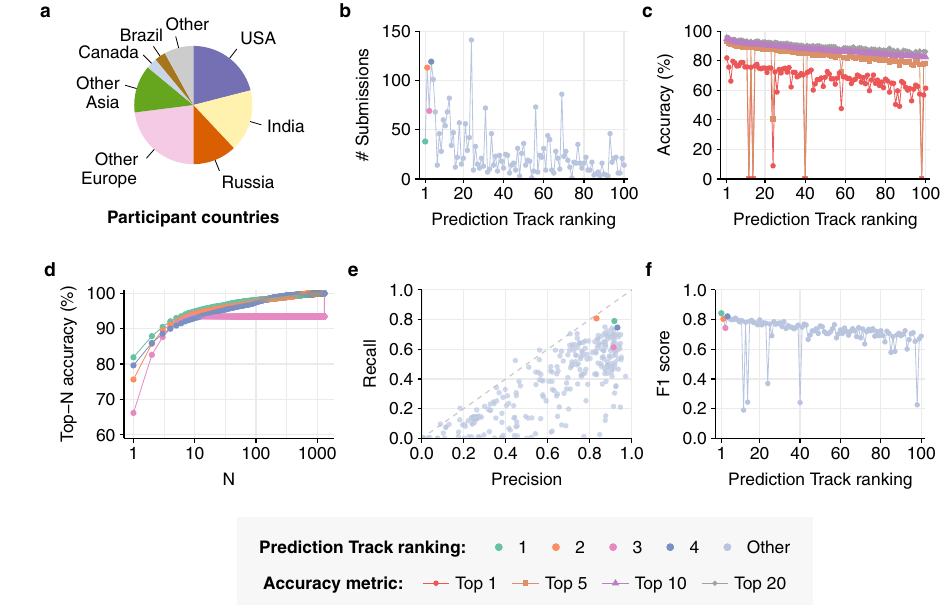
Fig. 2 | Key Competition Results. a Countries of residence of registered compe- titionparticipants. b Totalnumber ofsubmissions made by the top 100Prediction Track teams. c Top-1, − 5, − 10 and − 20 accuracy achieved by each of the top 100 Prediction Track teams. Top-10 accuracy (purple) was used to determine overall ranking and prizes. In all cases, top-5 accuracy is equal to or greater than top-1